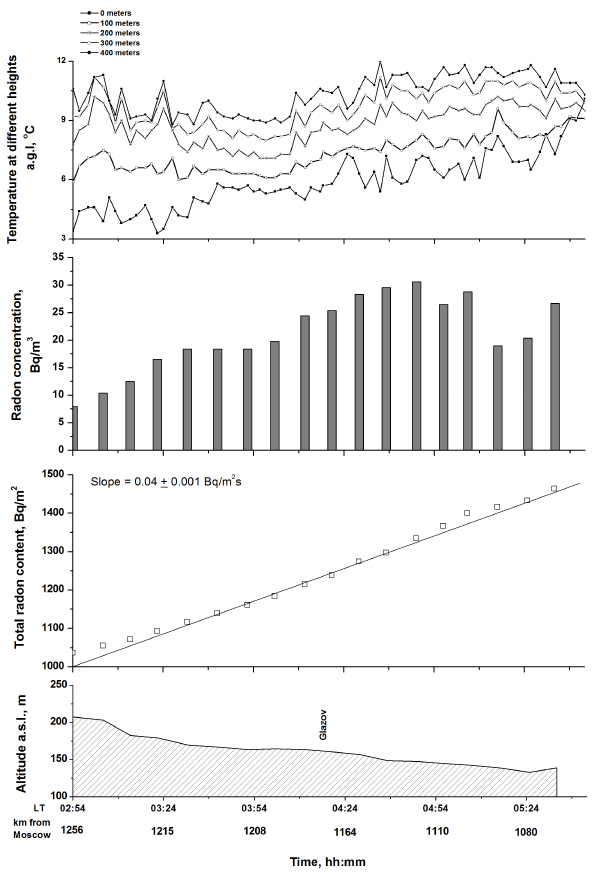
Table 6. Weighted mean 222 Rn fluxes (calculated using the maximum-likelihood method) in Russian regions in different sea- sons. The numbers of the regions (km from Moscow): I – Moscow-